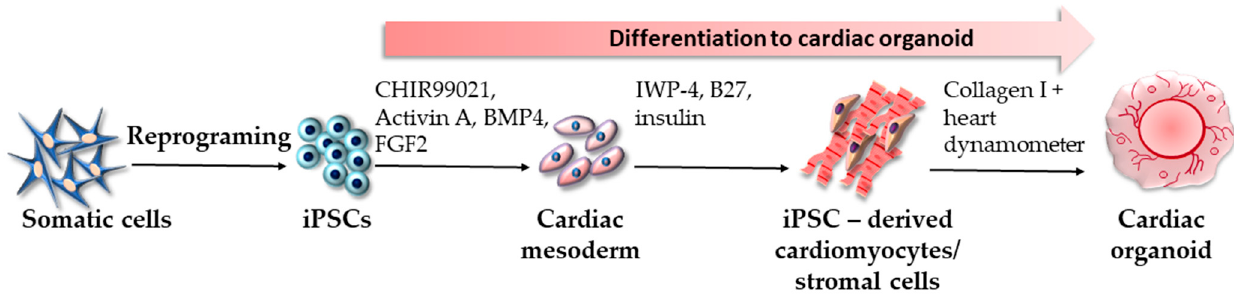
Figure 5. Generation of cardiac organoids according to the protocol by Mills et al. [118] .